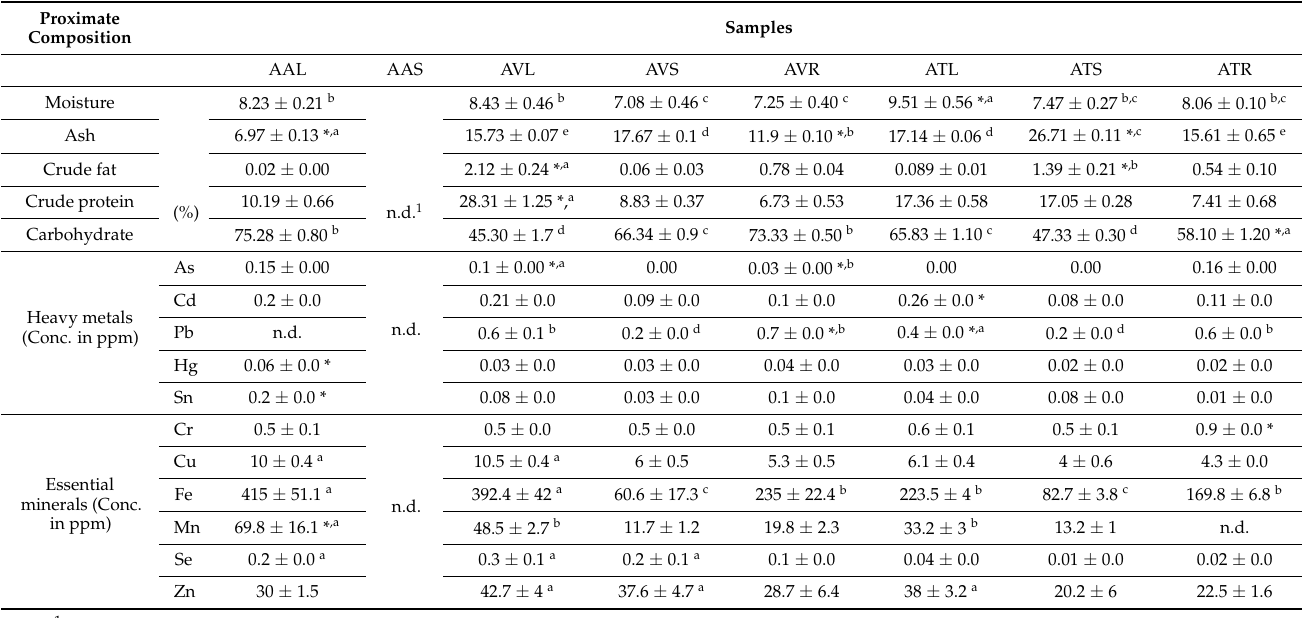
Table 1. Proximate contents in the processed